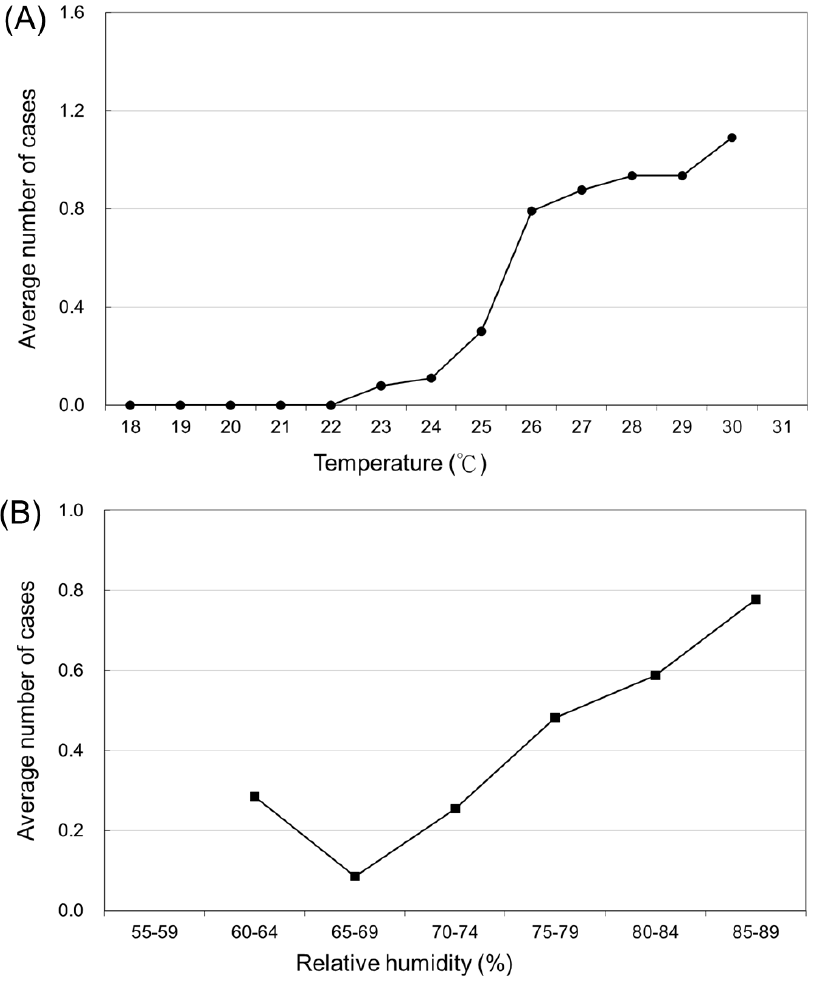
Figure 2. ( A ) The average number of Japanese encephalitis virus infections in various temperature domains. ( B ) The average number of Japanese encephalitis virus infections in various relative humidity domains.